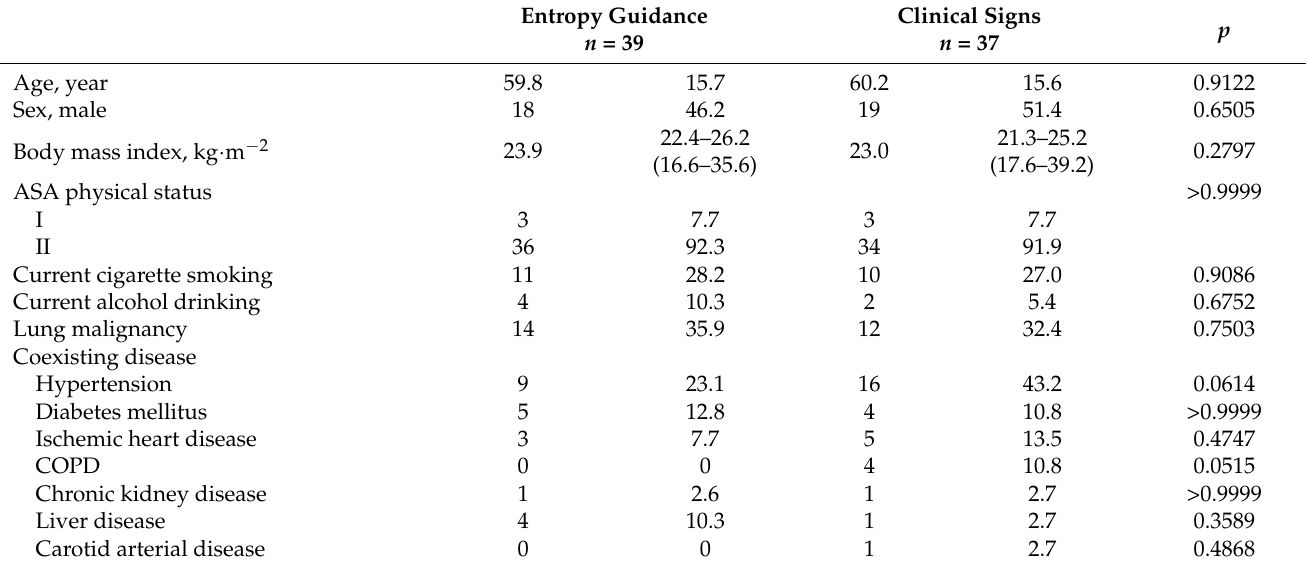
Table 1. Baseline characteristics of enrolled